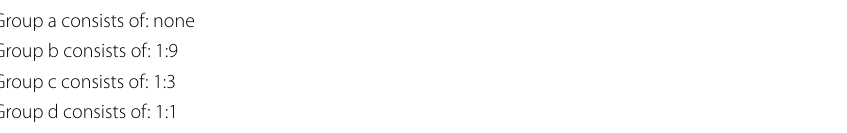
Table 29 HSD test groupings after ANOVA of AUPRC for the RUS